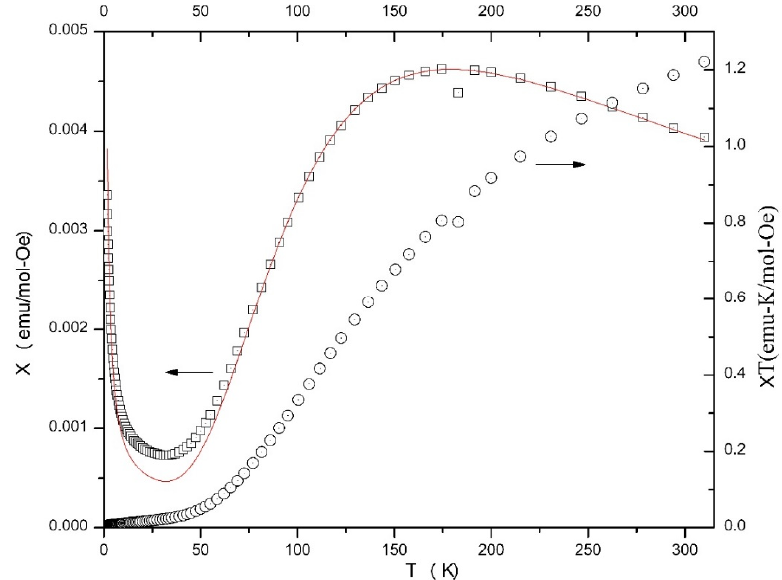
Figure 9. χ vs. T and χ T vs. T plots for compound 1 . Arrows on the plots indicate which y -axis. Applies to which data. The solid line is the best fit of the χ vs. T data to the S = 1 / 2 dimer model; see the text for details.